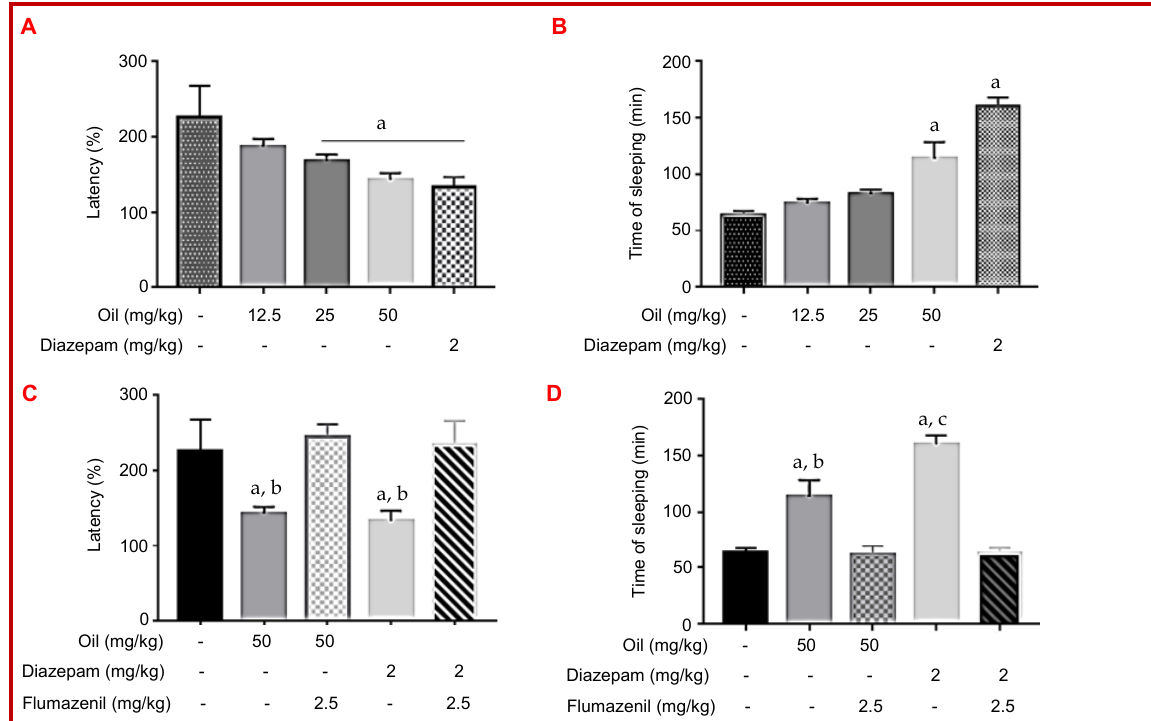
Figure 2: Effect of essential oil of P. lentiscus in the thiopental-induced sleeping time test and latency (n=6/group). Data are ex- pressed as mean ± SEM, where ‘a’, ‘b’ and ‘c’ indicate p<0.05, significant difference from the treated group according to AN OVA one-way followed by the Kruskal Wallis